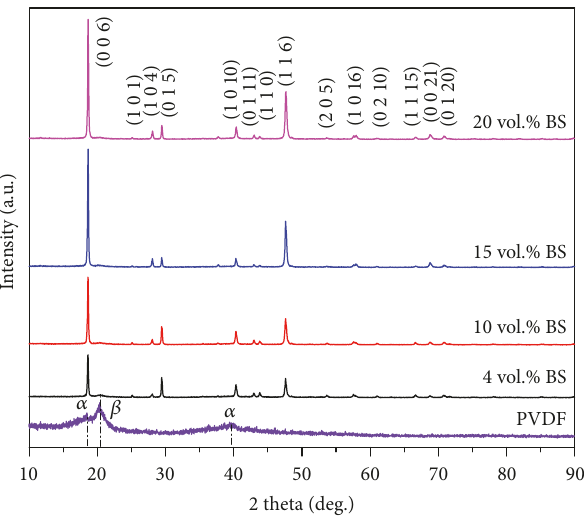
Figure 5: XRD pattern of pure PVDF film and the representative Bi 2 Se 3 /PVDF composite films filled with 4 vol.%, 10 vol.%, 15 vol.%, and 20 vol.% Bi 2 Se 3